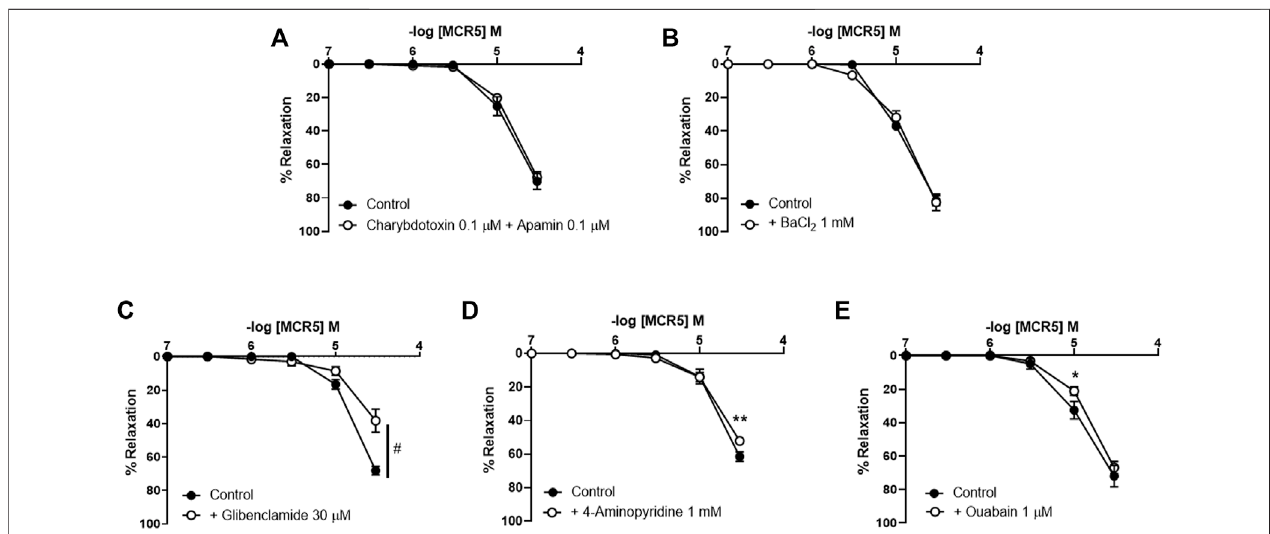
FIGURE5| EffectsofinhibitionofK + channelsandtheNa + /K + -ATPaseonMCR5relaxations.Concentration-responsecurvestoMCR5inU46619-pre-contracted aortic rings from young OF1 mice in the absence (control) or presence of the Ca 2+ -activated K + channels inhibitors charybdotoxin (0.1 µM) and apamin (0.1 µM) (A) , the inwardly rectifying K + channel blocker BaCl 2 (1 mM) (B) , the K ATP channel blocker glibenclamide (30 µM) (C) , the voltage-gated K + channel blocker 4-aminopyridine (1 mM) (D) ,andtheNa + /K + -ATPaseinhibitorouabain (1 μ M) (E) .Resultsaremean±SEMfrom n =6 (A) ,5 (B) ,7 (C) ,6 (D,E) mice. # p < 0.05bytwo-way repeated measures ANOVA; p p < 0.05, pp p < 0.01 by two-way repeated measures ANOVA with Bonferroni ’ s post hoc test.